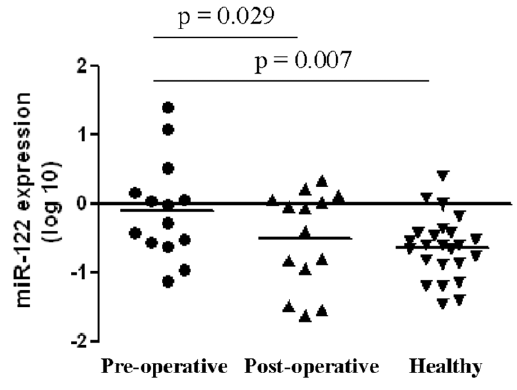
Figure 3. Expression levels of miR-122 in pre-operative, post- operative and healthy serum samples. The levels of miR-122 were significantly reduced in the post-operative serum samples (n=14) when compared to the pre-operative samples (n=14), reaching levels comparable with healthy subjects (n=24).